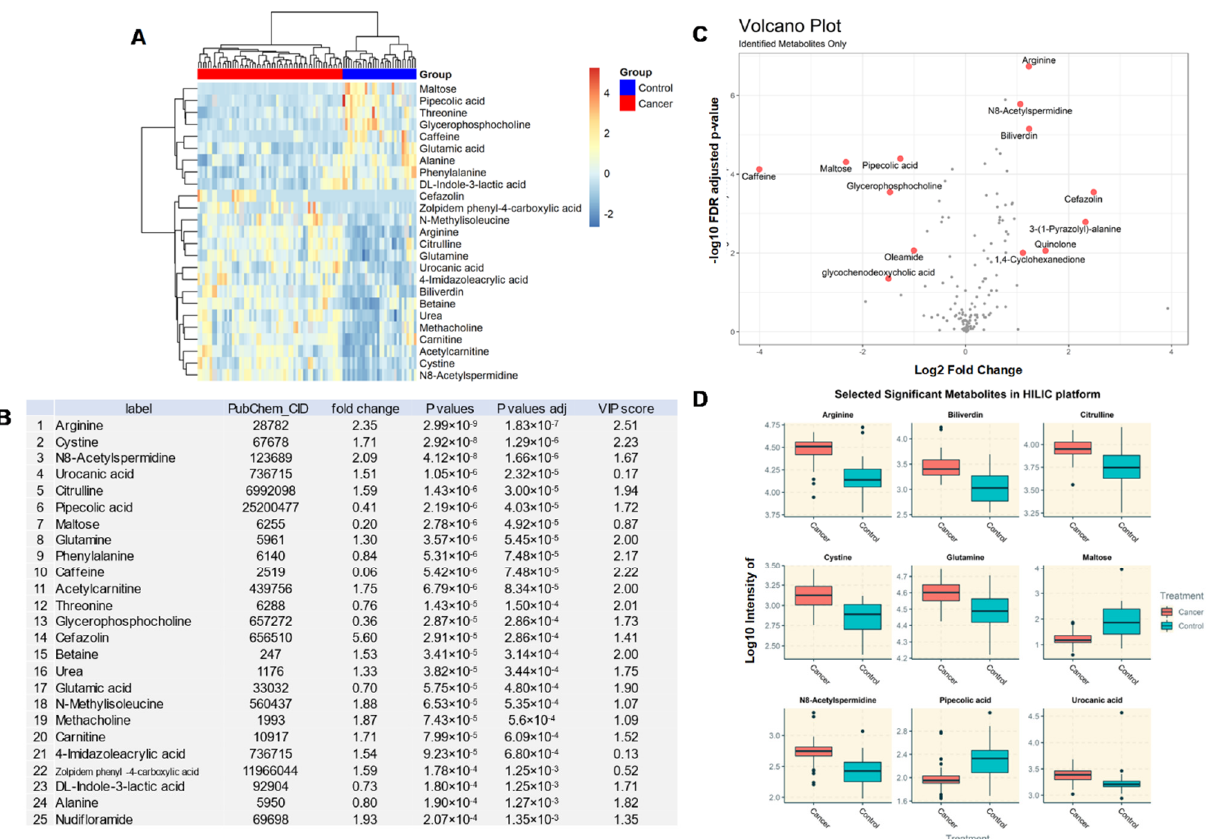
Figure 3. ( A ) Heatmap of identified metabolites in HILIC platform with the top 25 DEMs with the smallest Mann–Whitney U test p -values, comparing BC to control. Euclidean distance metric and Ward’s clustering method was used for the hierarchical clustering of samples and compounds. ( B ) The 25 identified metabolites are listed. Fold-changes are presented as the median average of cancer divided by control. False discovery rate-adjusted p -values using the Benjamini–Hochberg procedure are reported at the last column. VIP score for each compound is reported in Figure 3B (VIP > 1 highlighted as red). ( C ) Volcano plot visualizes the − log10 adjusted p -values and log2 fold-changes. Metabolites with adjusted p -values less than 0.05 and fold-change greater than 2-fold or less than 0.5 fold are highlighted and labeled. ( D ) Select example metabolite boxplots from the HILIC platform showing significant differences between BC and control.